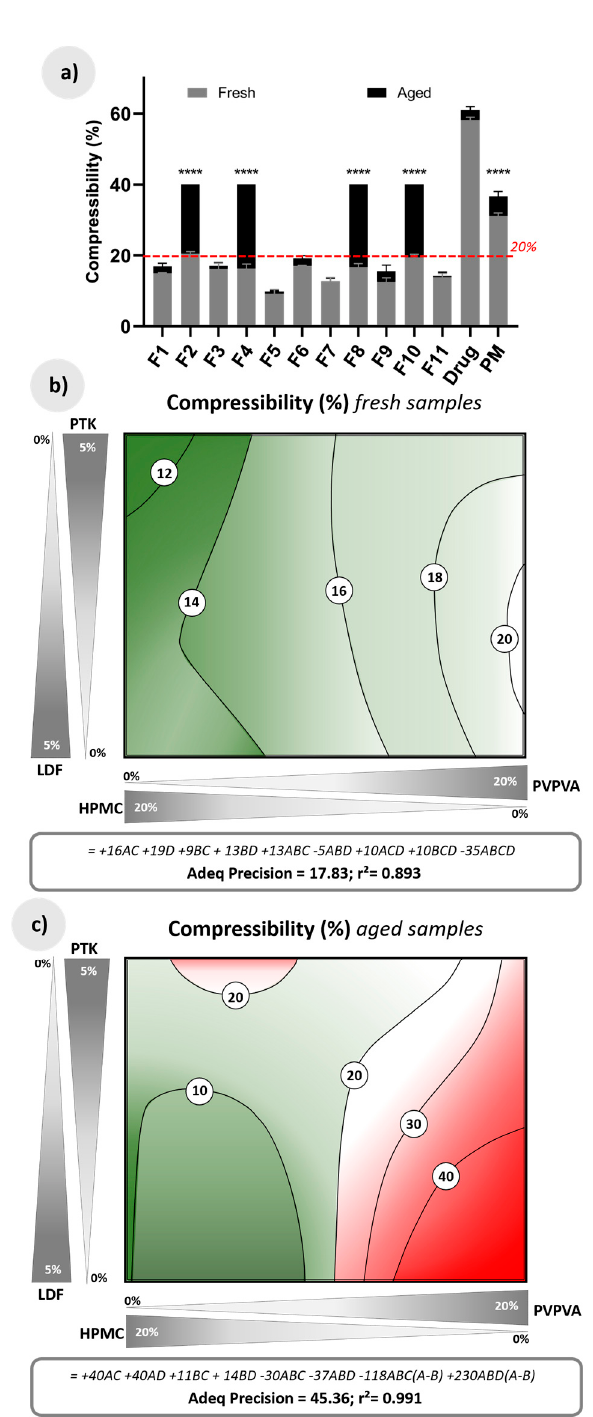
Figure 6. ( a ) Compressibility (%) of fresh and aged raw material drug, physical mixture of drug and effervescent salts (PM), and effervescent extrudates; ( b ) Response surface for compressibility in fresh extrudates according to a quadratic-quadratic model, together with its predictive equation; ( c ) Response surface for compressibility in aged extrudates according to a cubic-linear model, together with its predictive equation. A = PVPVA, B = HPMC, C = PTK, and D = LDF. The red dotted line in ( a ) marks the limit for an appropriate flow; the green regions in ( b ) and ( c ) show compositions within particle flee flow, and the red regions in ( c ) indicate compositions with cohesive particles. **** ( p < 0.0001).